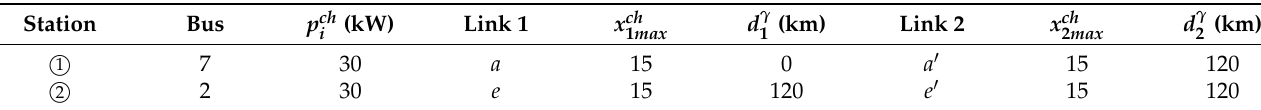
Table 5. Parameters of FCSs.